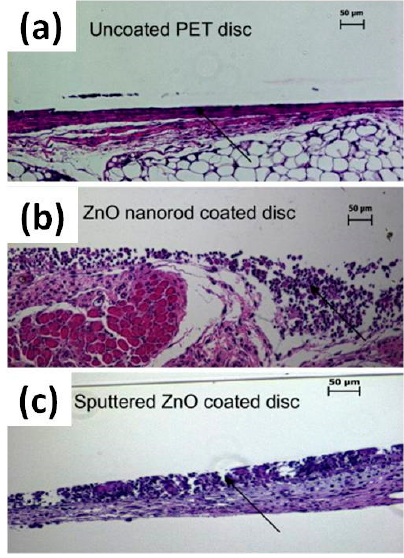
Figure 11. Zinc oxide coatings on implanted discs prevent formation of acellular fibrous capsules around discs, indicative of unresolved inflammation. ( a ) Verhoeff-van-Geisson stained section (collagen pink; cell nuclei: dark blue) of tissue response to implanted biomaterials. Uncoated polyethylene terephthalate (PET) disc has a smooth, relatively acellular fibrous capsule formed around the disc, indicated by the arrow; ( b ) PET discs coated with ZnO nanorods did not have an acellular fibrous capsule formed around discs; ( c ) PET discs coated with sputtered ZnO also did not have an acellular fibrous capsule formed around discs. On the contrary, the ZnO-coated discs demonstrate a lack of fibrous capsule formation and an accumulation of recruited inflammatory cells (indicated by arrows). Scale bar is 50 μ m. Modified with permission from reference [94]. Copyright (2010) Elsevier.